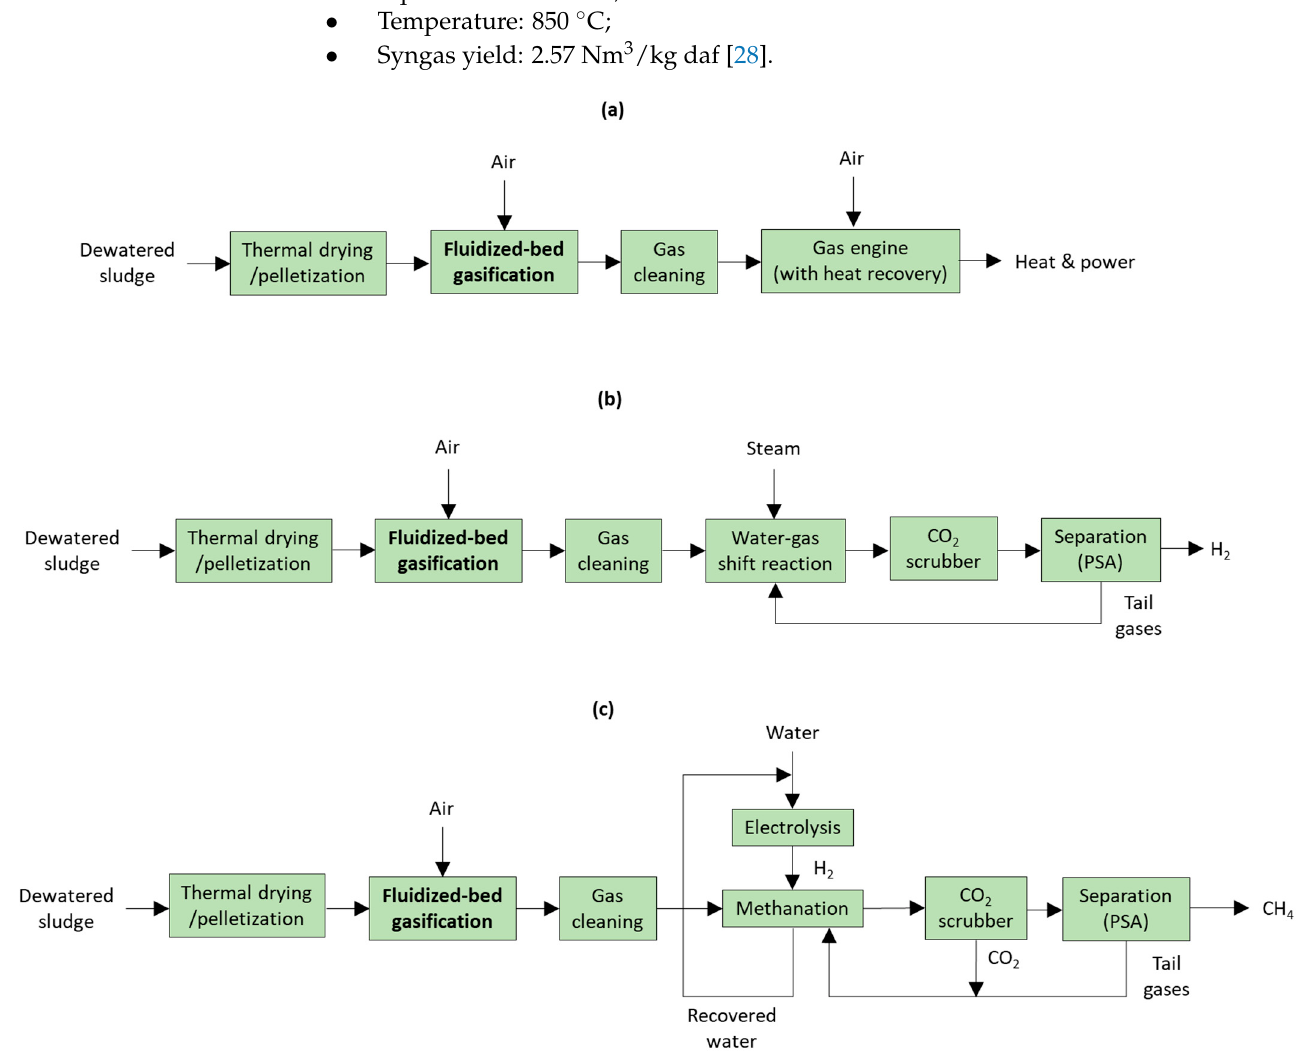
Figure 1. Configuration scenarios for energy and renewable-gas production from dewatered-sludge gasification: ( a ) CHP production; ( b ) hydrogen production; ( c ) bio-SNG production. gasification: ( a ) CHP production; ( b ) hydrogen production; ( c ) bio-SNG